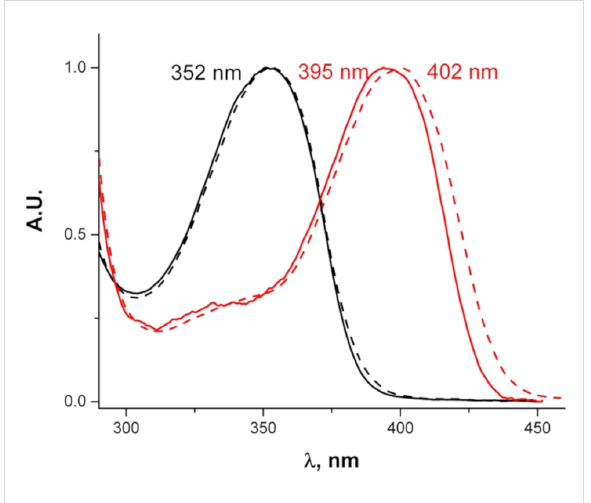
Figure 8: Absorption spectra of 10a (black), 10b (red). Solid curves: in toluene, dashed curves: in